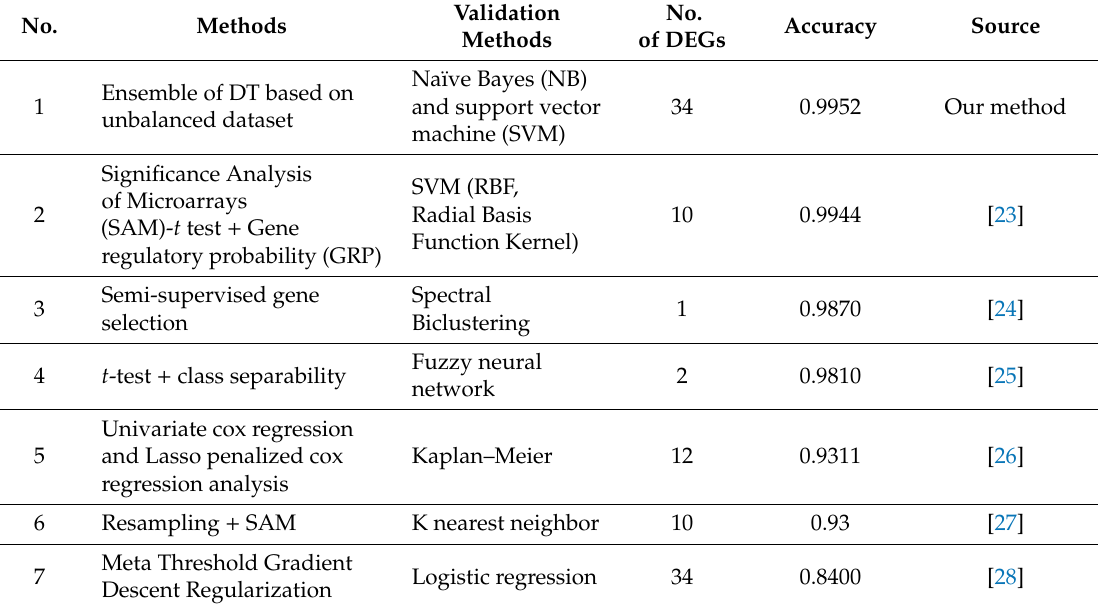
Table 1. Comparison of classification results obtained by di ff erent methods in the hepatocellular carcinoma (HCC)